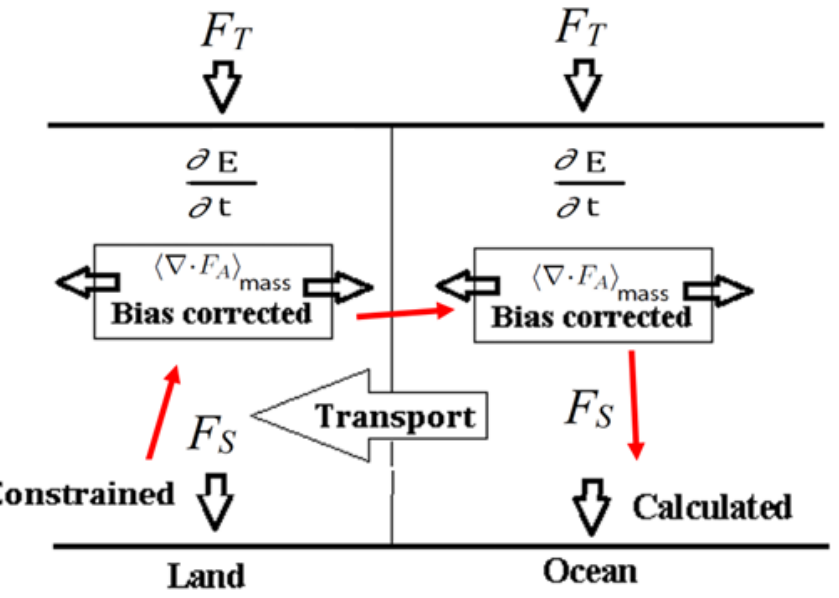
Figure 3. Schematic diagram showing the energy flow in the climate system. The land surface flux is constrained by new observations, the atmospheric divergences over land and ocean are adjusted to respond to this constraint, and the surface energy fluxes can be estimated using the residual method. Red arrows indicate the adjustment sequence after the land surface flux is constrained.